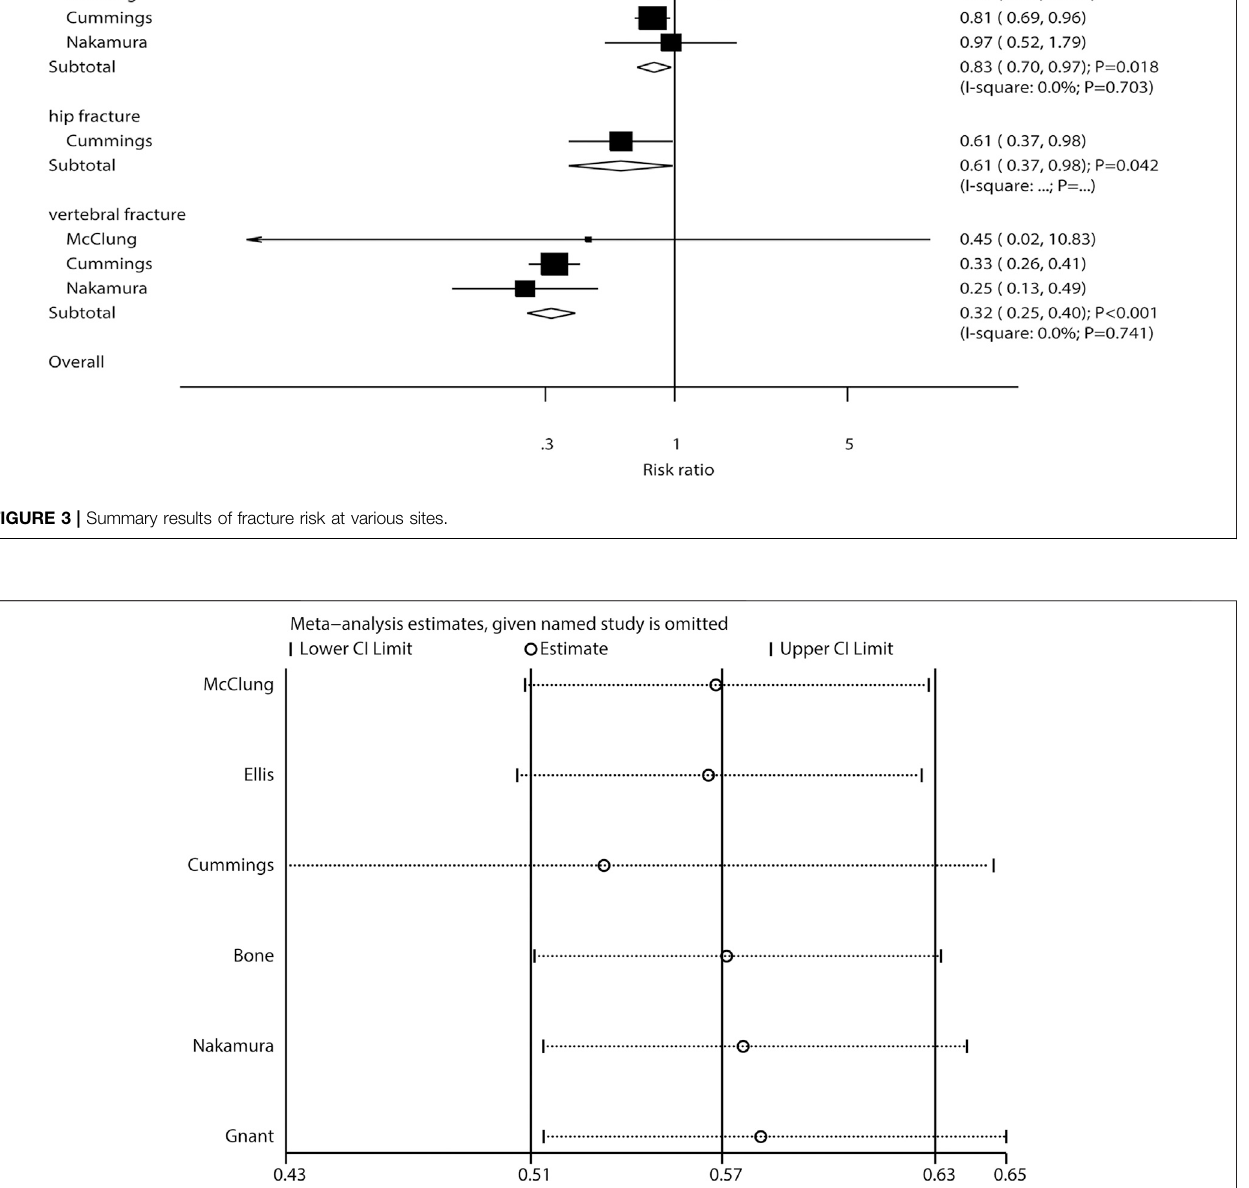
Frontiers in Pharmacology |